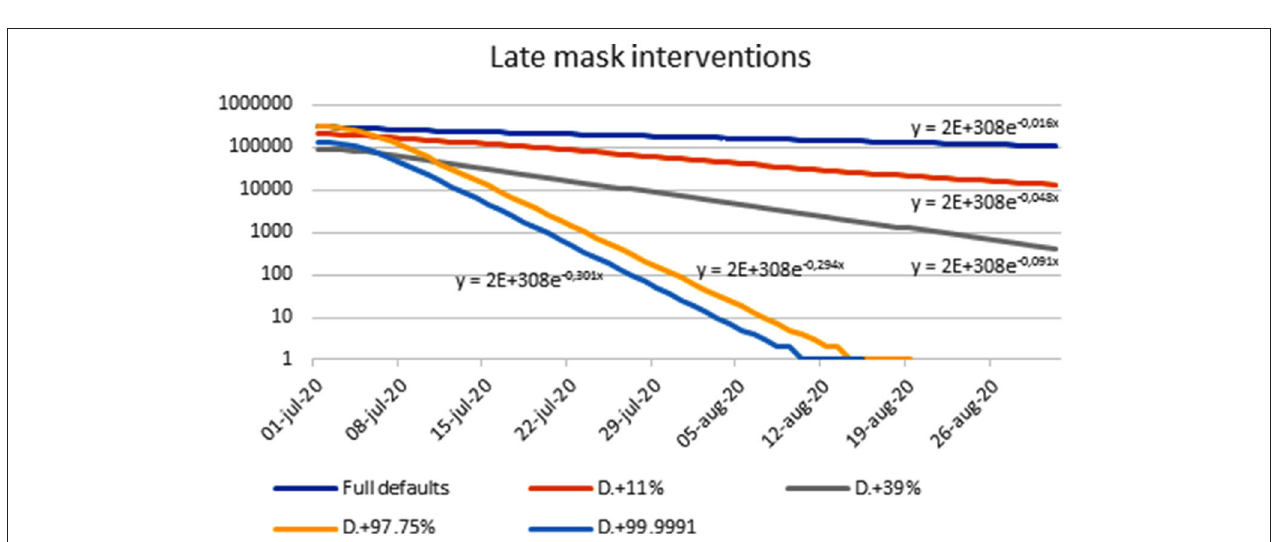
FIGURE 7 | Estimating half-life and weekly reduction from the late use of four different masks (cases 1–4); vertical axis is “infectious” individuals from COVID-19 Scenarios.